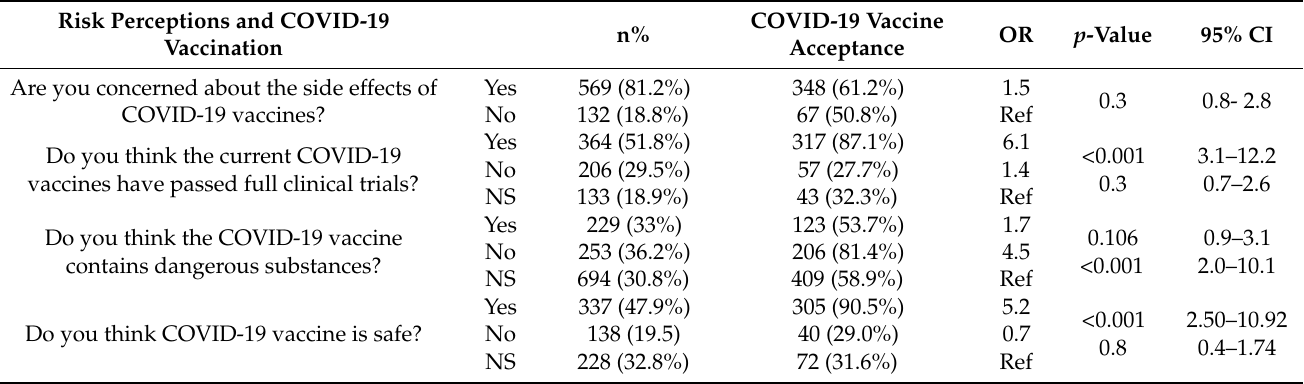
Table 3. Multinomial logistic regression of COVID-19 vaccine acceptance across risk perception